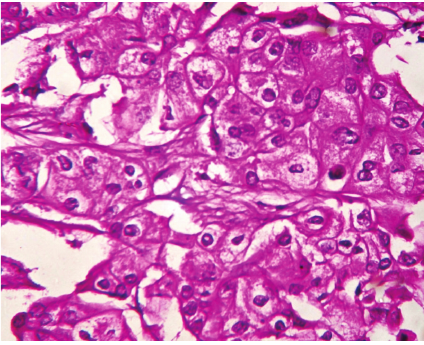
Figure 2: Photomicrograph showing large tumor cells having abundant granular eosinophilic cytoplasm and large round nuclei (H&E: